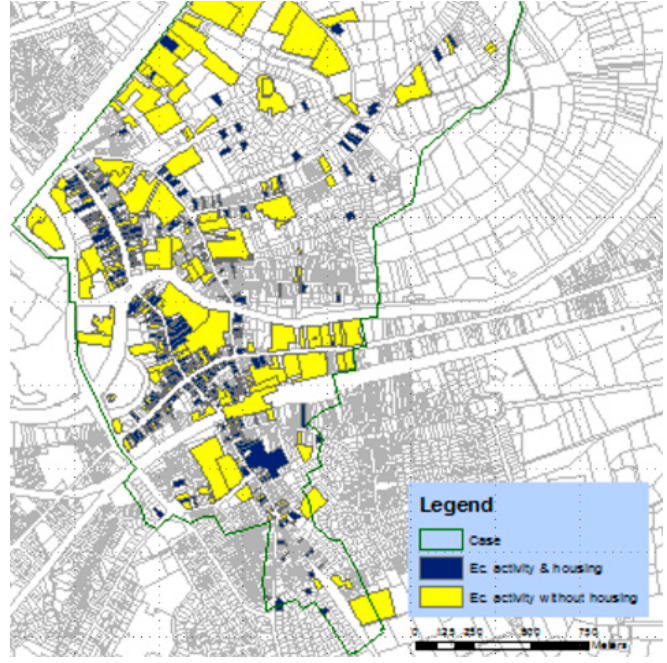
Figure 4. Combination of economic activities with housing (Deinze). Table 2. Detected parcels with an economic function per location environment.